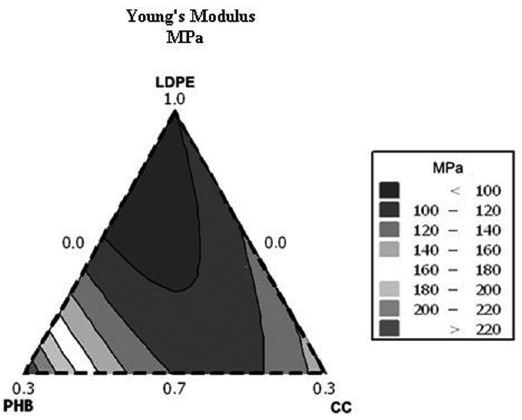
Figure 2. Response surface plot of Young`s modulus.